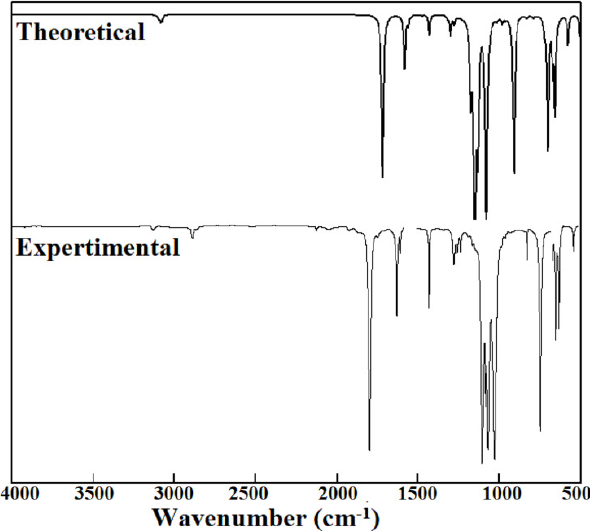
Figure 5. Simulated IR spectrum (top) and experimental FTIR spectrum (bottom) for